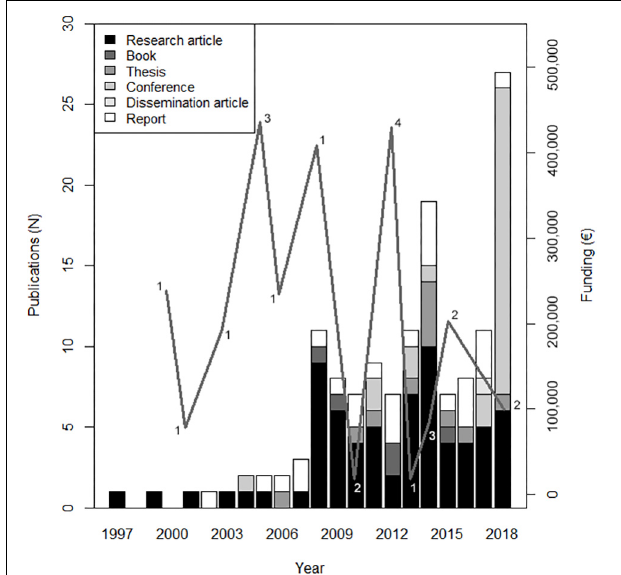
FIGURE 2 | Number of research texts about marine recreational fisheries in Spain published by year up to 2018, grouped by category. Line shows the annual funding invested in research projects in the same period (figures show the number of projects by